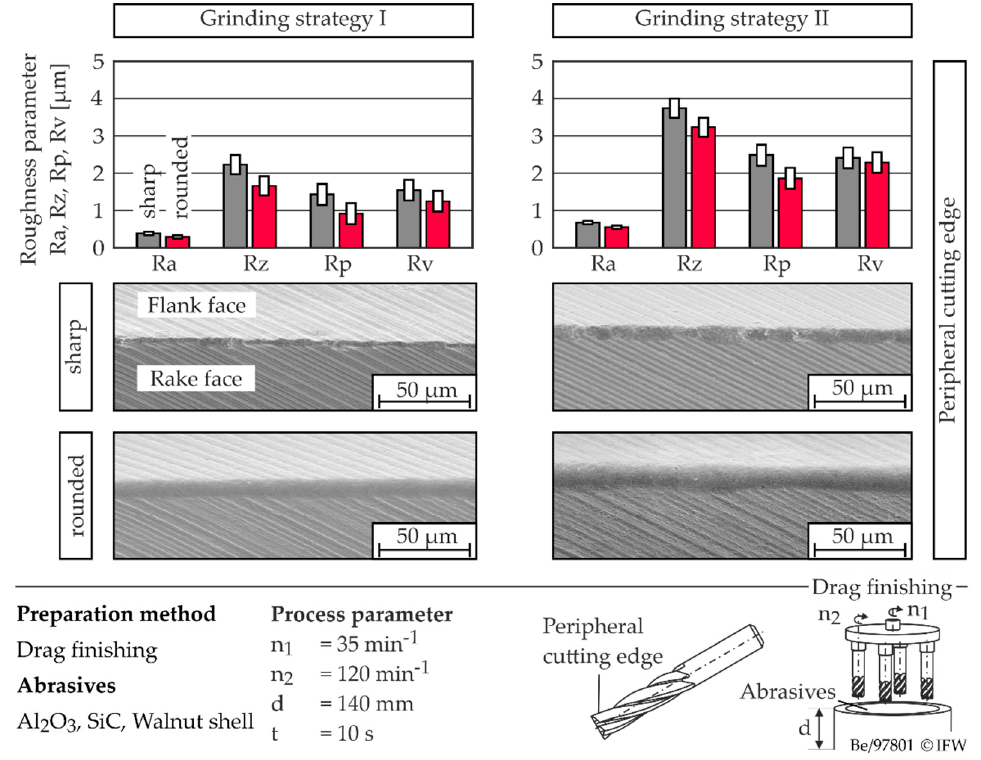
Figure 5. Influence of edge preparation on roughness along the cutting edge.